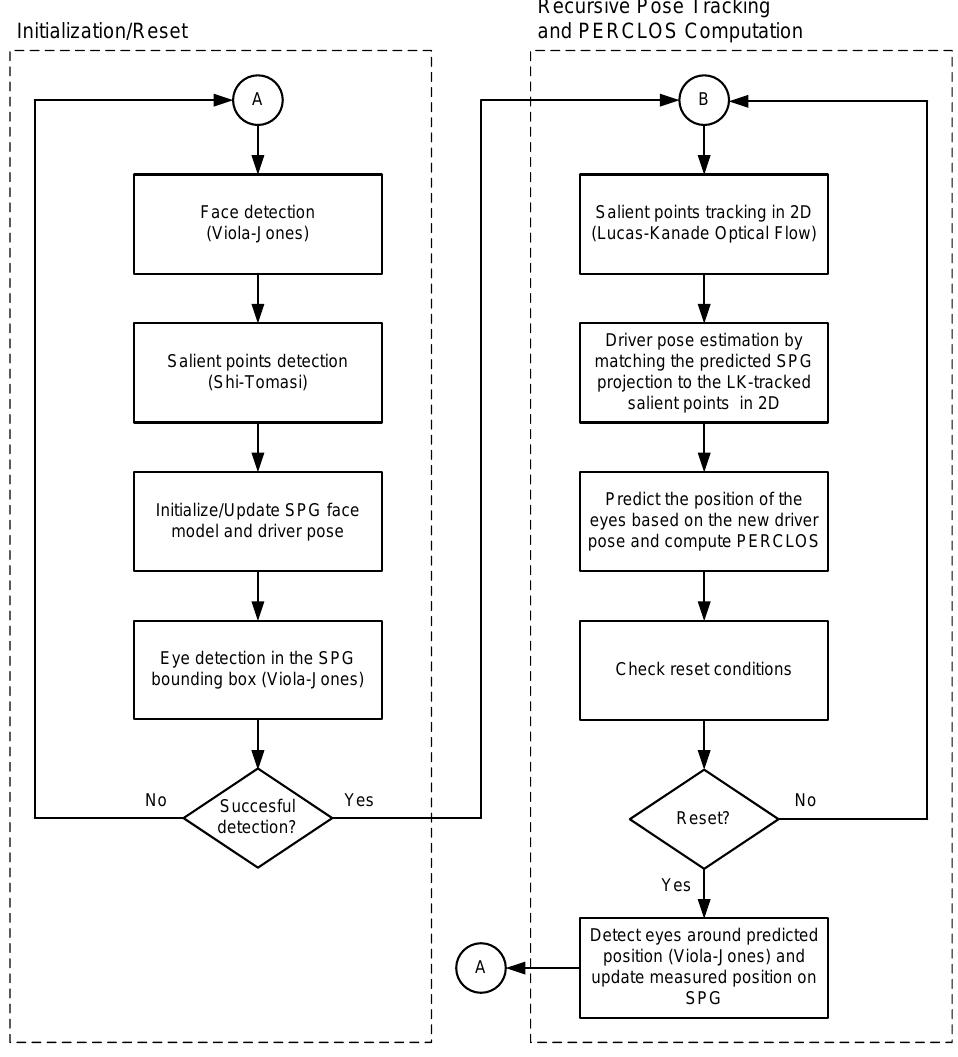
Figure 2. Flow chart of the proposed